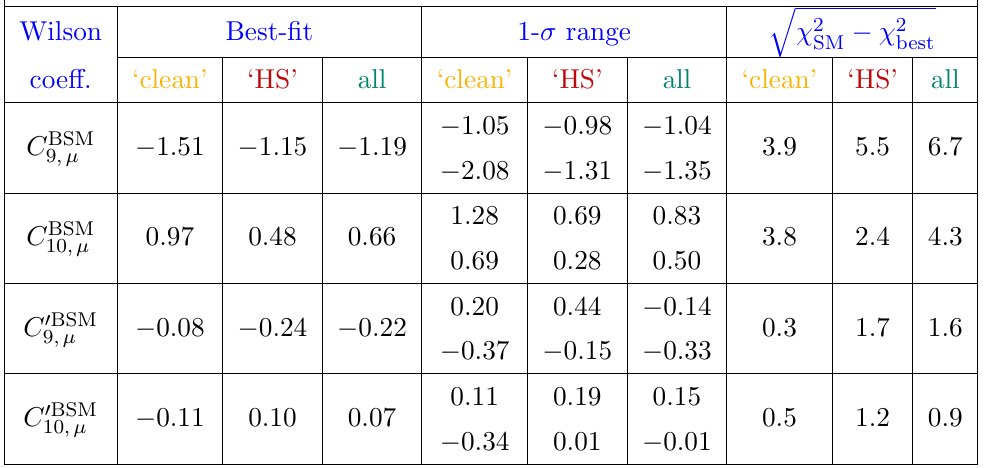
Table 2 . Same as table 1, but in the vector-axial